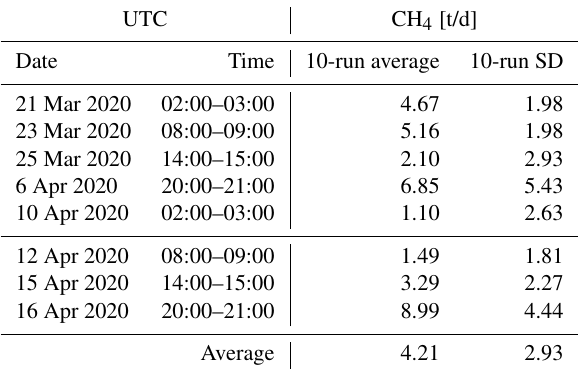
Table 2. Emissions error results of Monte Carlo